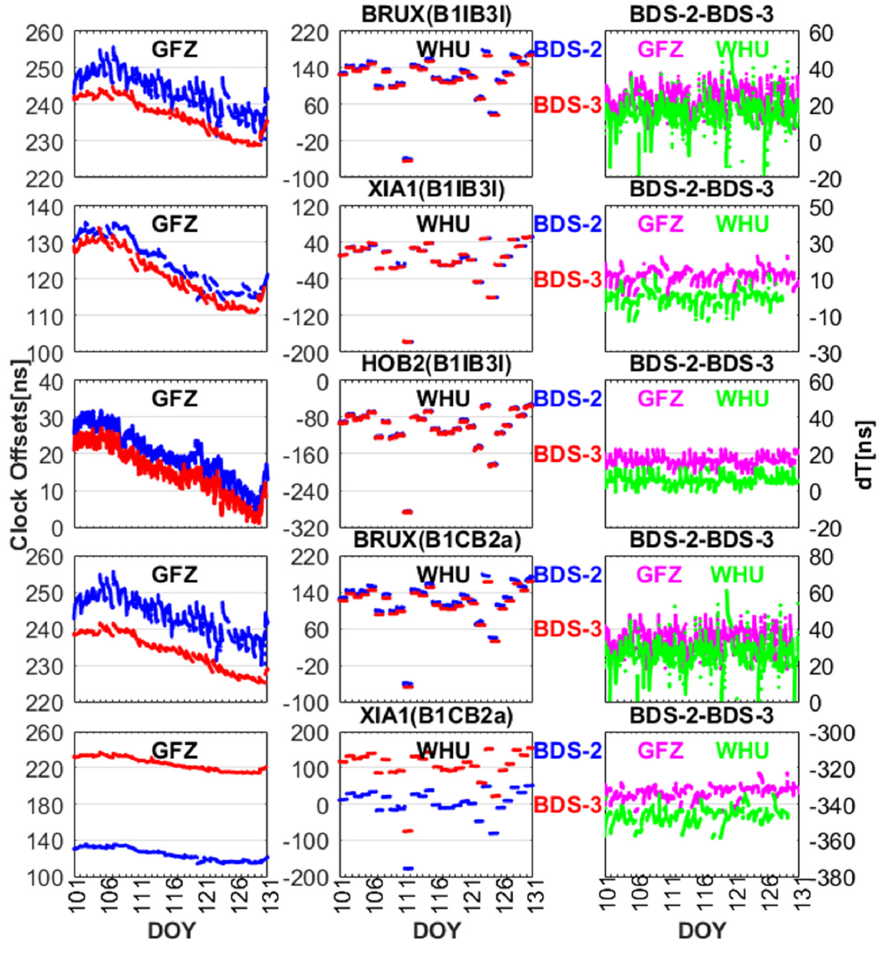
Figure 4. The receiver clock offsets of BDS-2-only and BDS-3-only for new signals (B1C/B2a) and old signals (B1I/B3I) at stations BRUX (SEPT POLARX5TR), XIA1 (GNSS-GGR), and HOB2 (SEPT POLARX5).